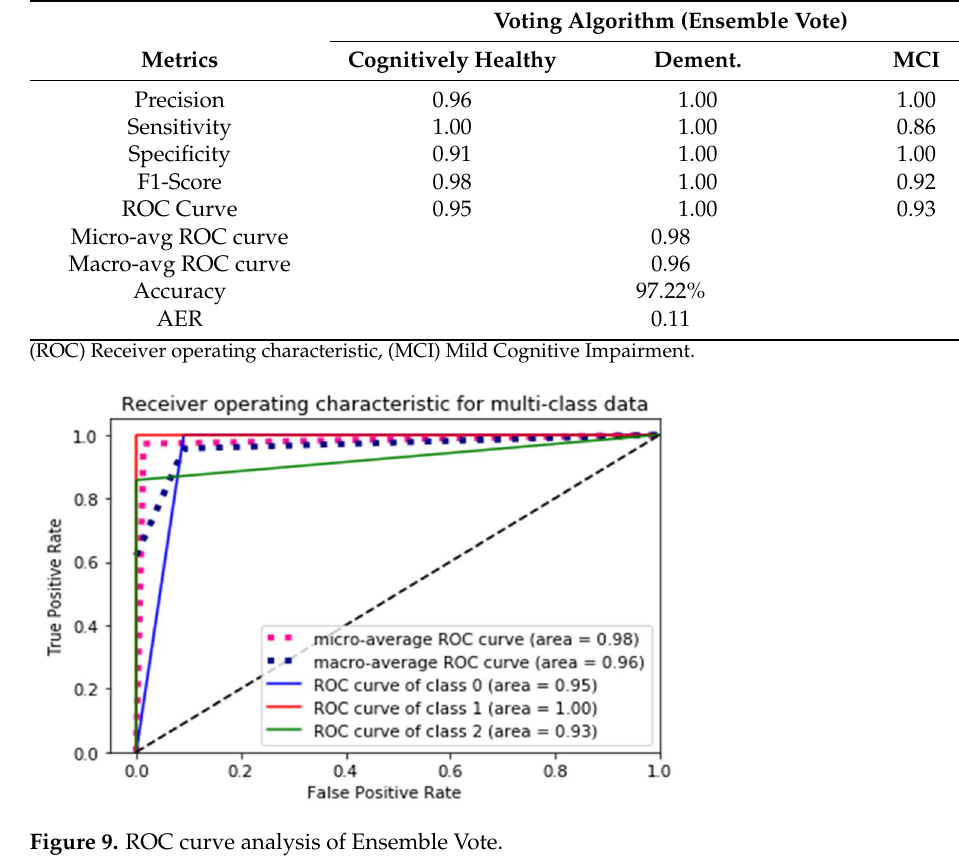
Table 5. Accuracy of testing data based on the percentage of training data.